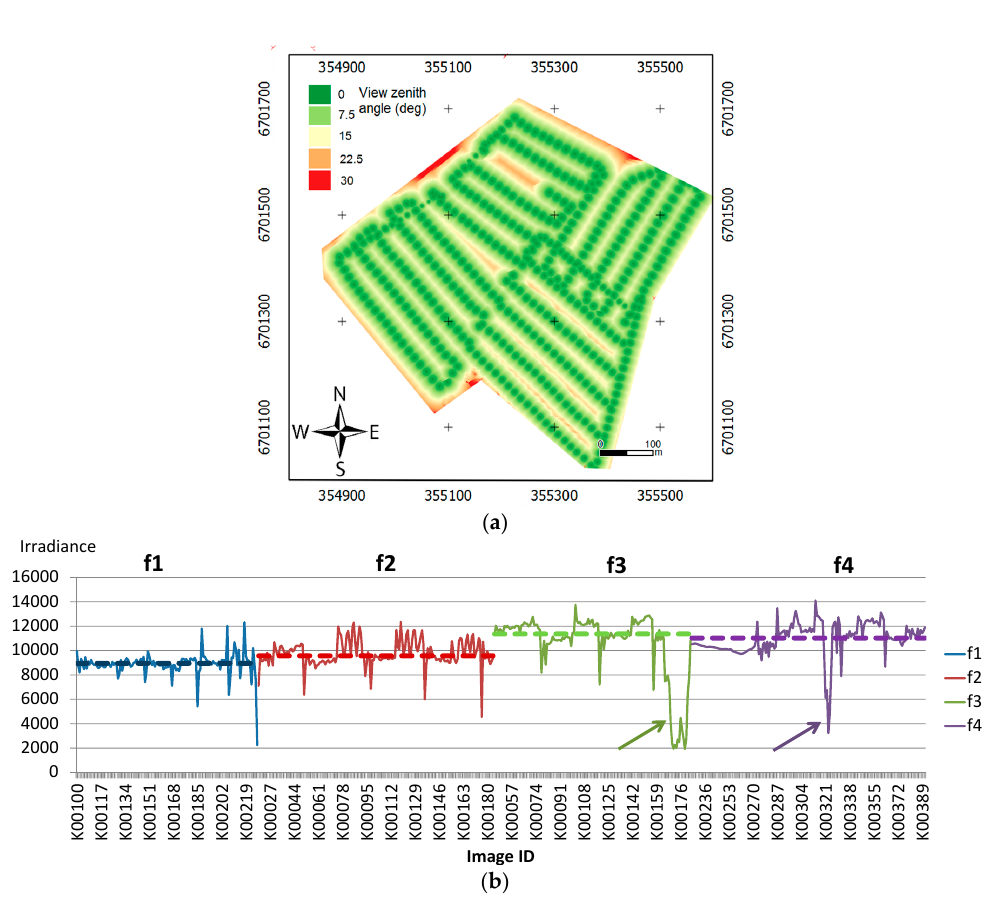
Figure 3. ( a ) View zenith angle to each point of image mosaics; ( b ) onboard irradiance recordings for each image during flights f1, f2, f3 and f4. The dashed lines are medians of irradiance recordings during each flight.